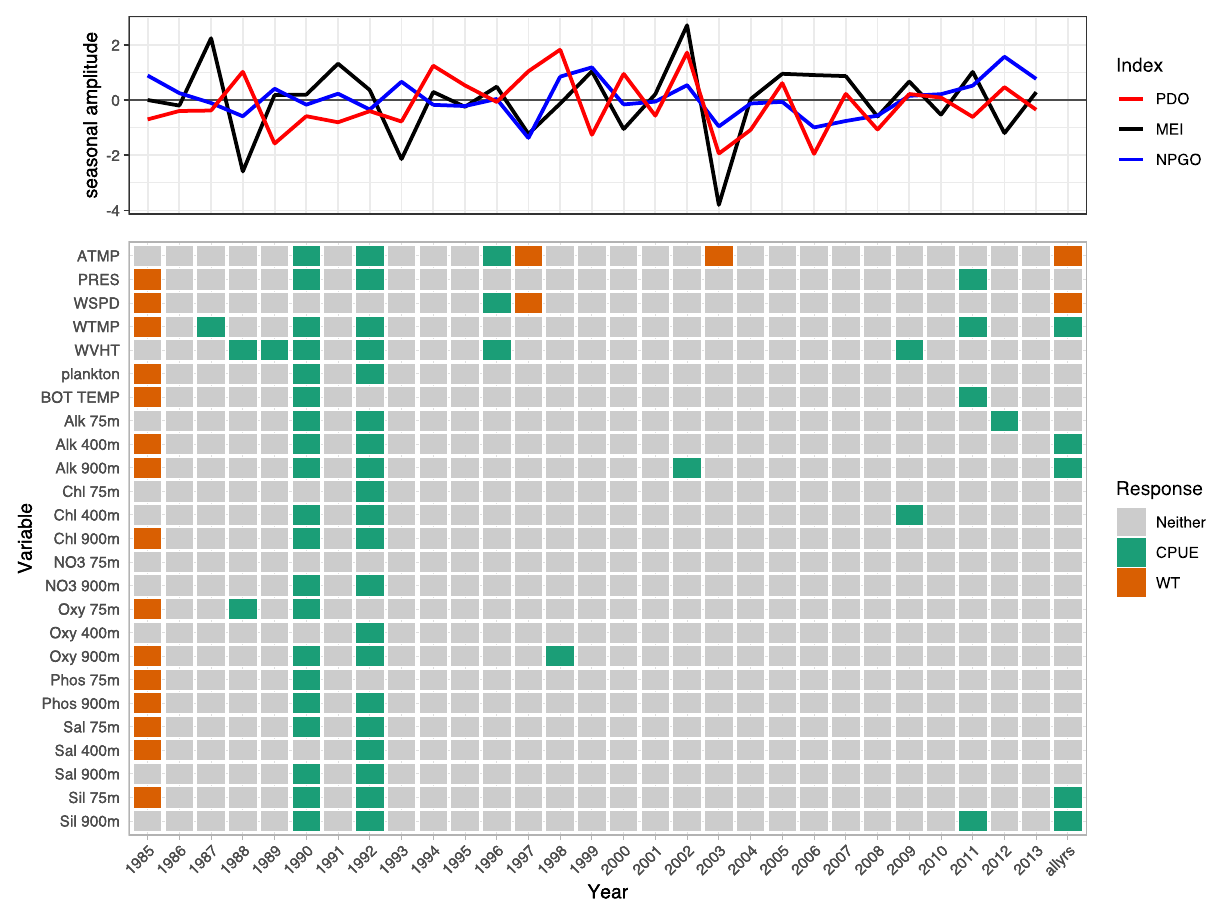
Figure 3. Variable selection analyzed for each available year and all years together for the SIVCMs with sablefish CPUE or WT as the response. Axes, colors, and line plot are as described in Fig.